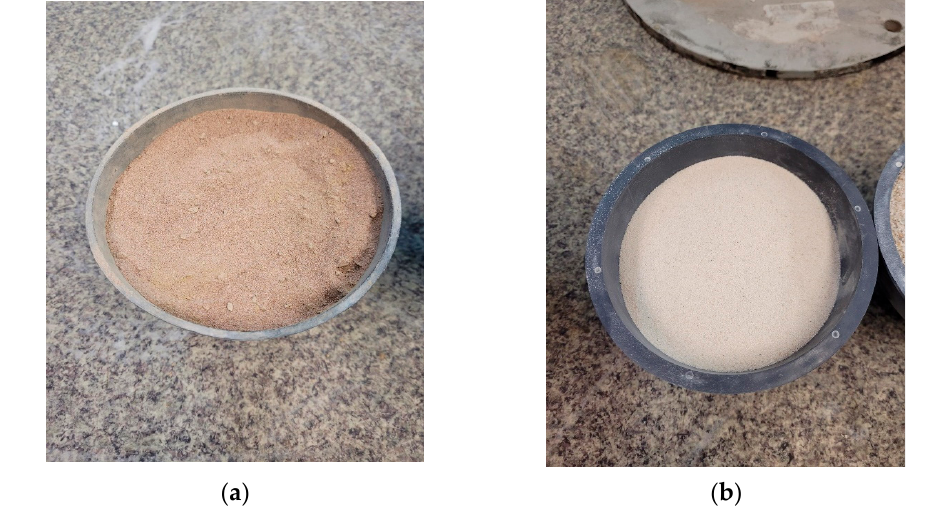
Figure 2. Comparison between aggregates ( a ) spent garnet ( b ) natural sand.